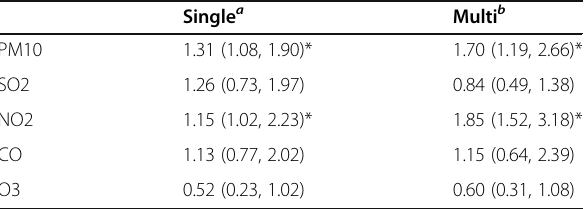
Table 5 Conditional logistic regression estimated adjusted odds ratios (ORs) and 95% confidence intervals (CIs) for associations of allergic rhinitis with ambient air pollution exposure among